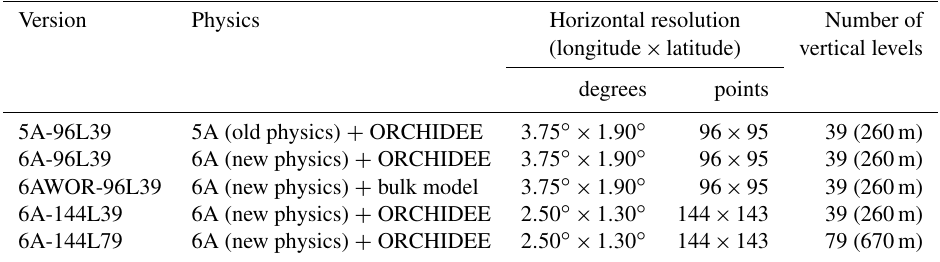
Table 1. Description of the simulations. The vertical spacing averaged over the tropics (between the surface and 10km) is indicated in